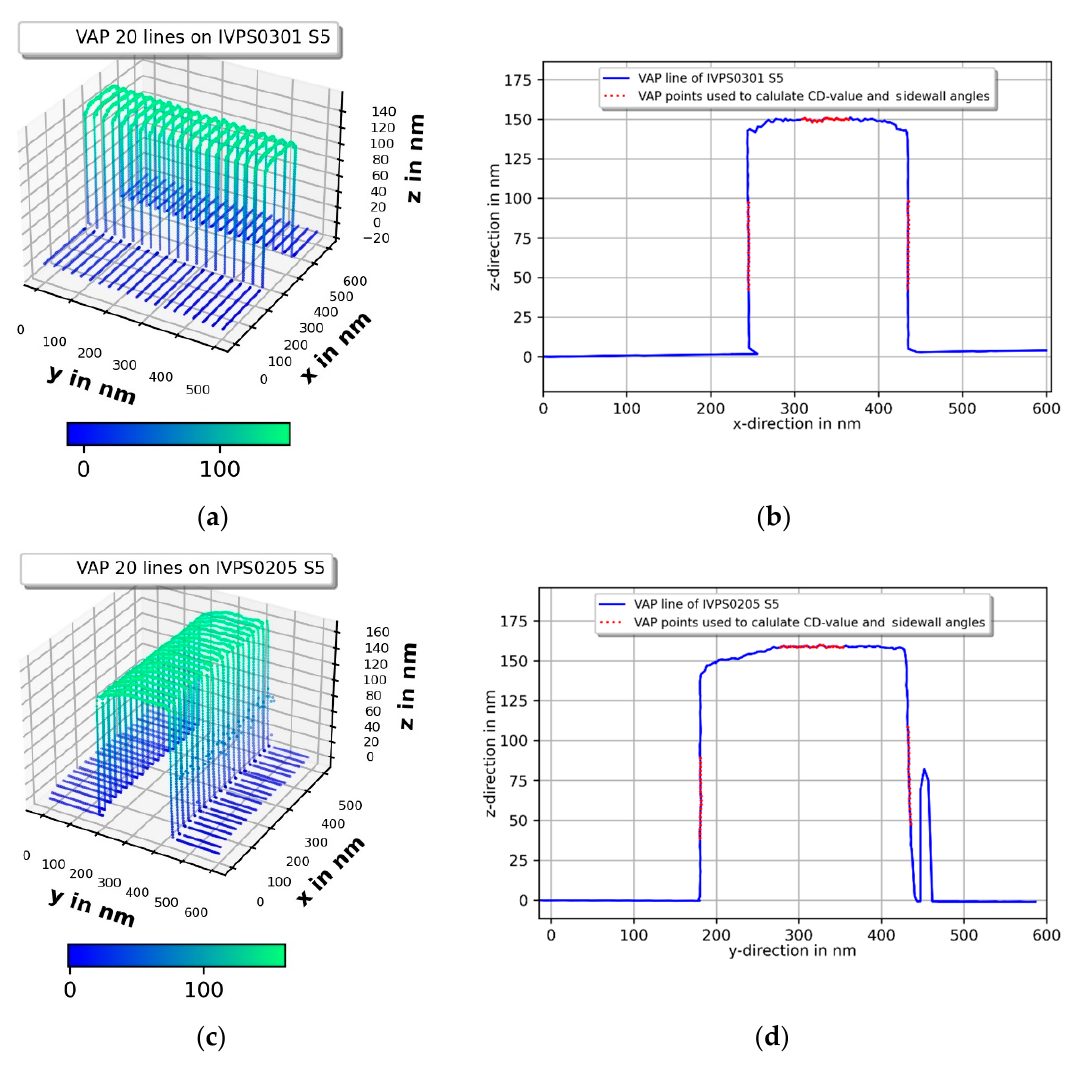
Figure 11. Vector approach probing (VAP) measurements (raw data) of the two IVPS100-PTB struc- tures IVPS0301 in ( a ) and IVPS0205 in ( c ) orthogonally mounted to each other. One measured line is shown in ( b ) and ( d ) for the x- and y-direction, respectively.